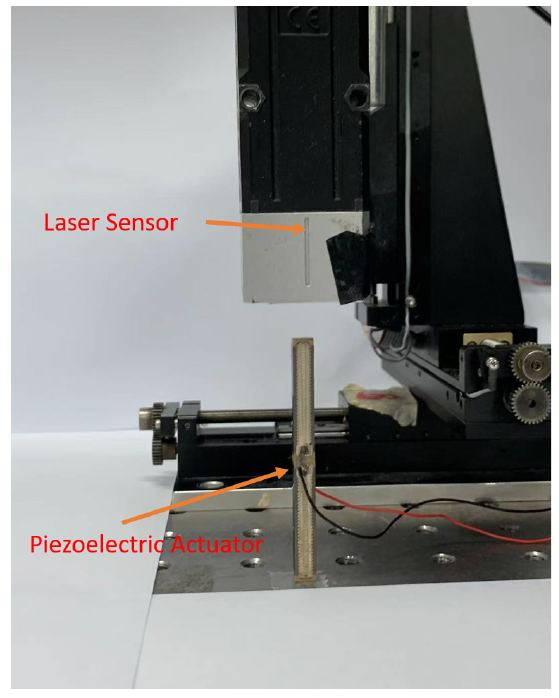
Figure 8. Experimental setup.